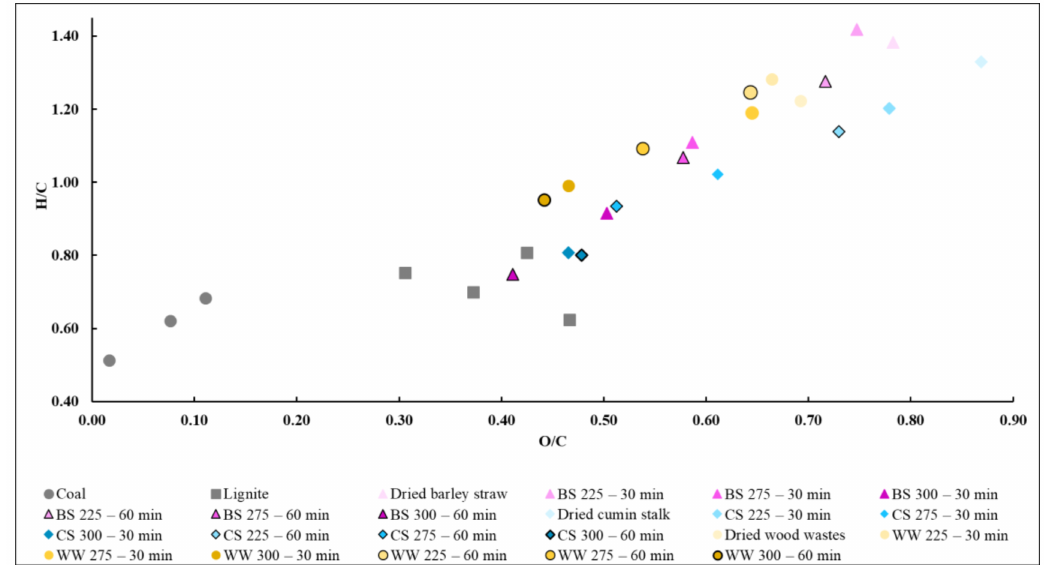
Figure 2. Van Krevelen diagram of dried and torrefied biomass. Coal and lignite data are adopted from Smith and Ross [31]. In contrast to O/C ratio, the high heating value of the fuel reduces with reducing H/C ratio. Torrefaction treatment reduces the hydrogen content in biomass. For example, the H/C ratio reduced from 1.22 to 0.99 for WW, from 1.38 to 0.92 for BS, and from 1.31 to 0.81 for CS, respectively, when biomass was torrefied at 300 ◦ C for 30